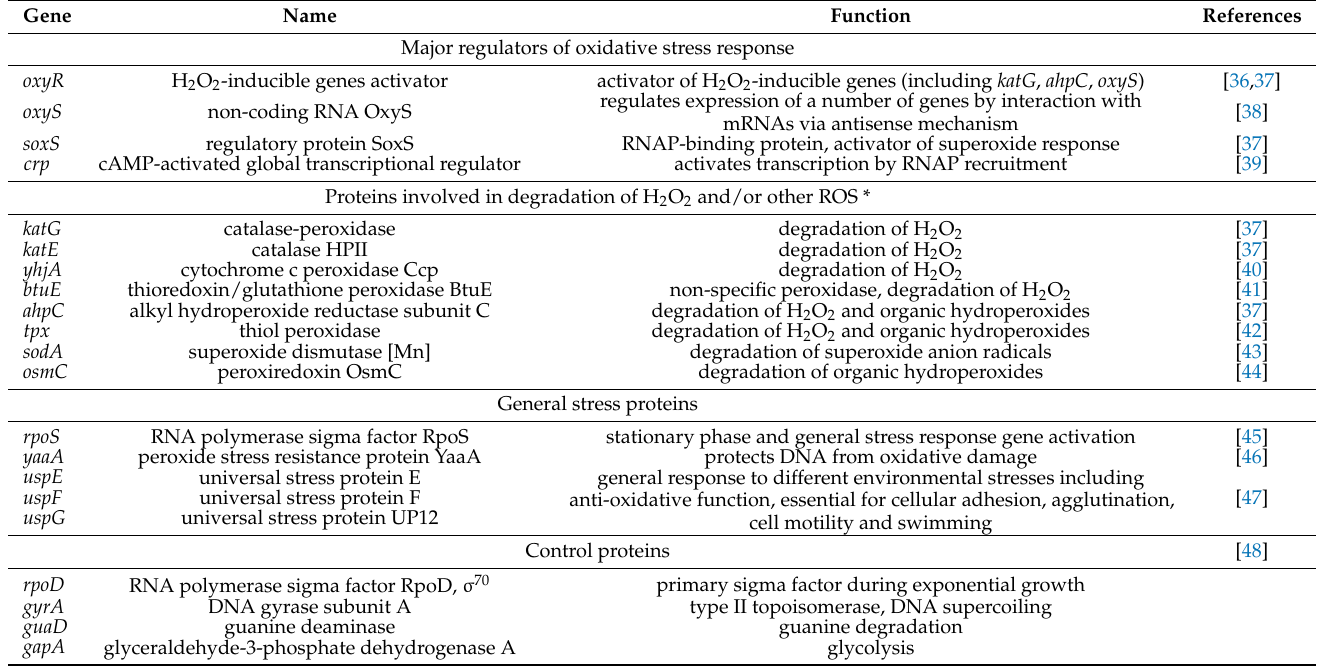
Table 1. Stress response genes selected for qRT-PCR